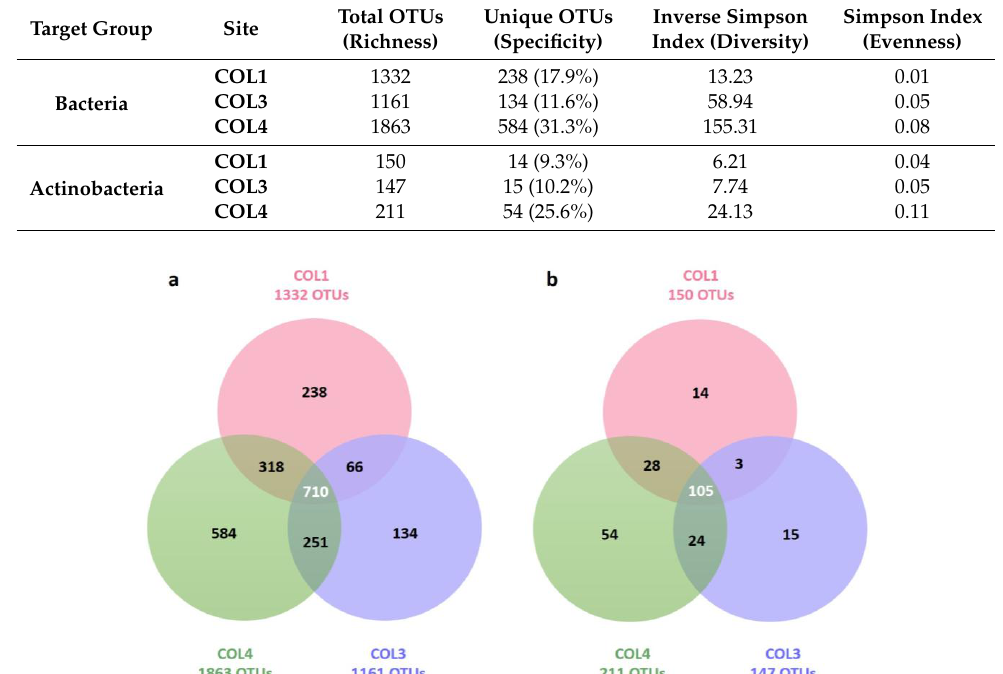
Table 1. Richness, specificity, diversity, and evenness of the bacterial and actinobacterial communities